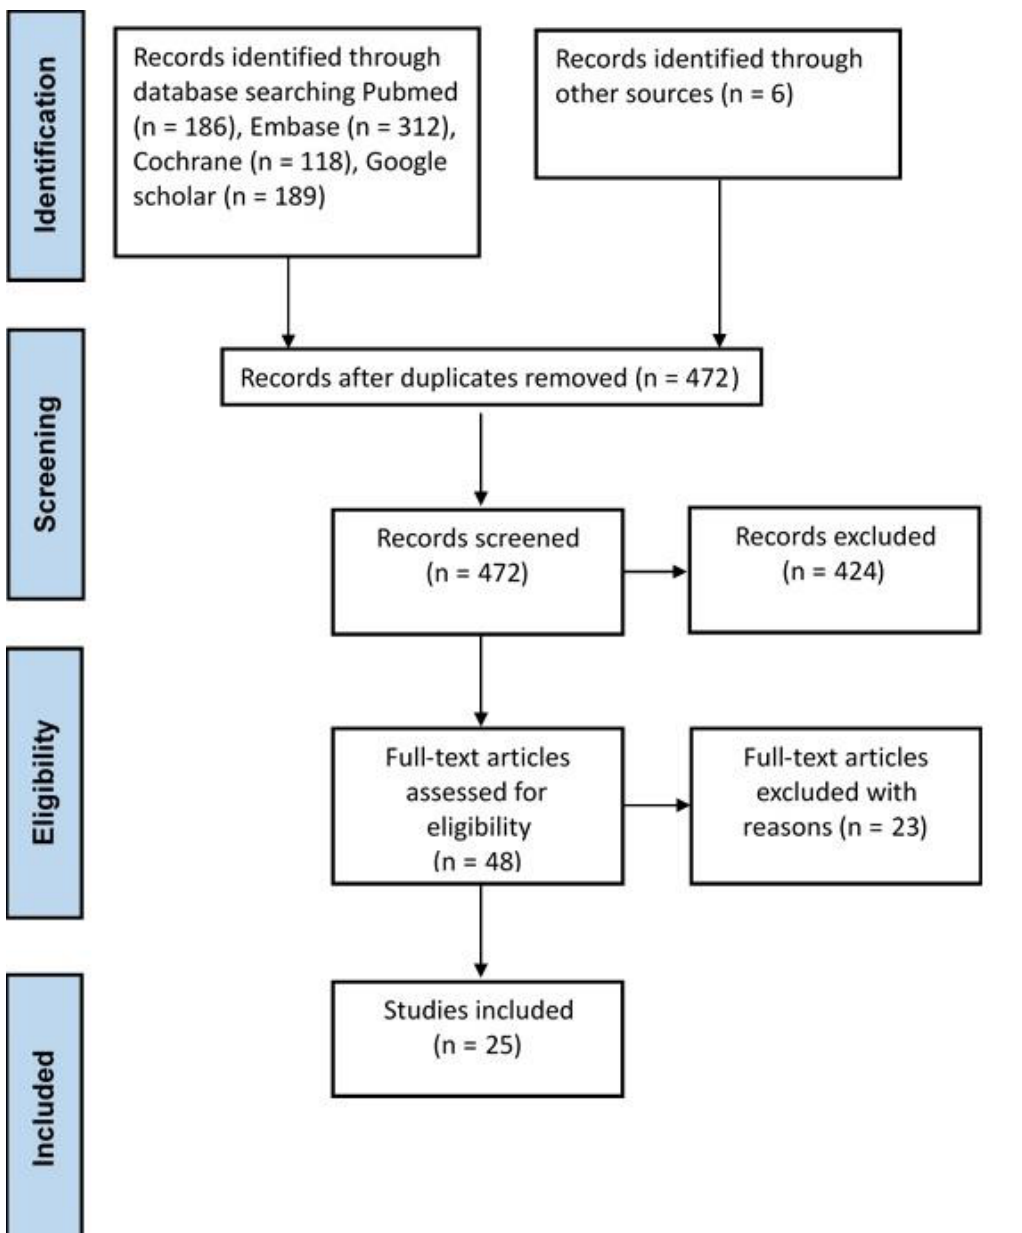
Figure 1. Flow diagram of study selection and search